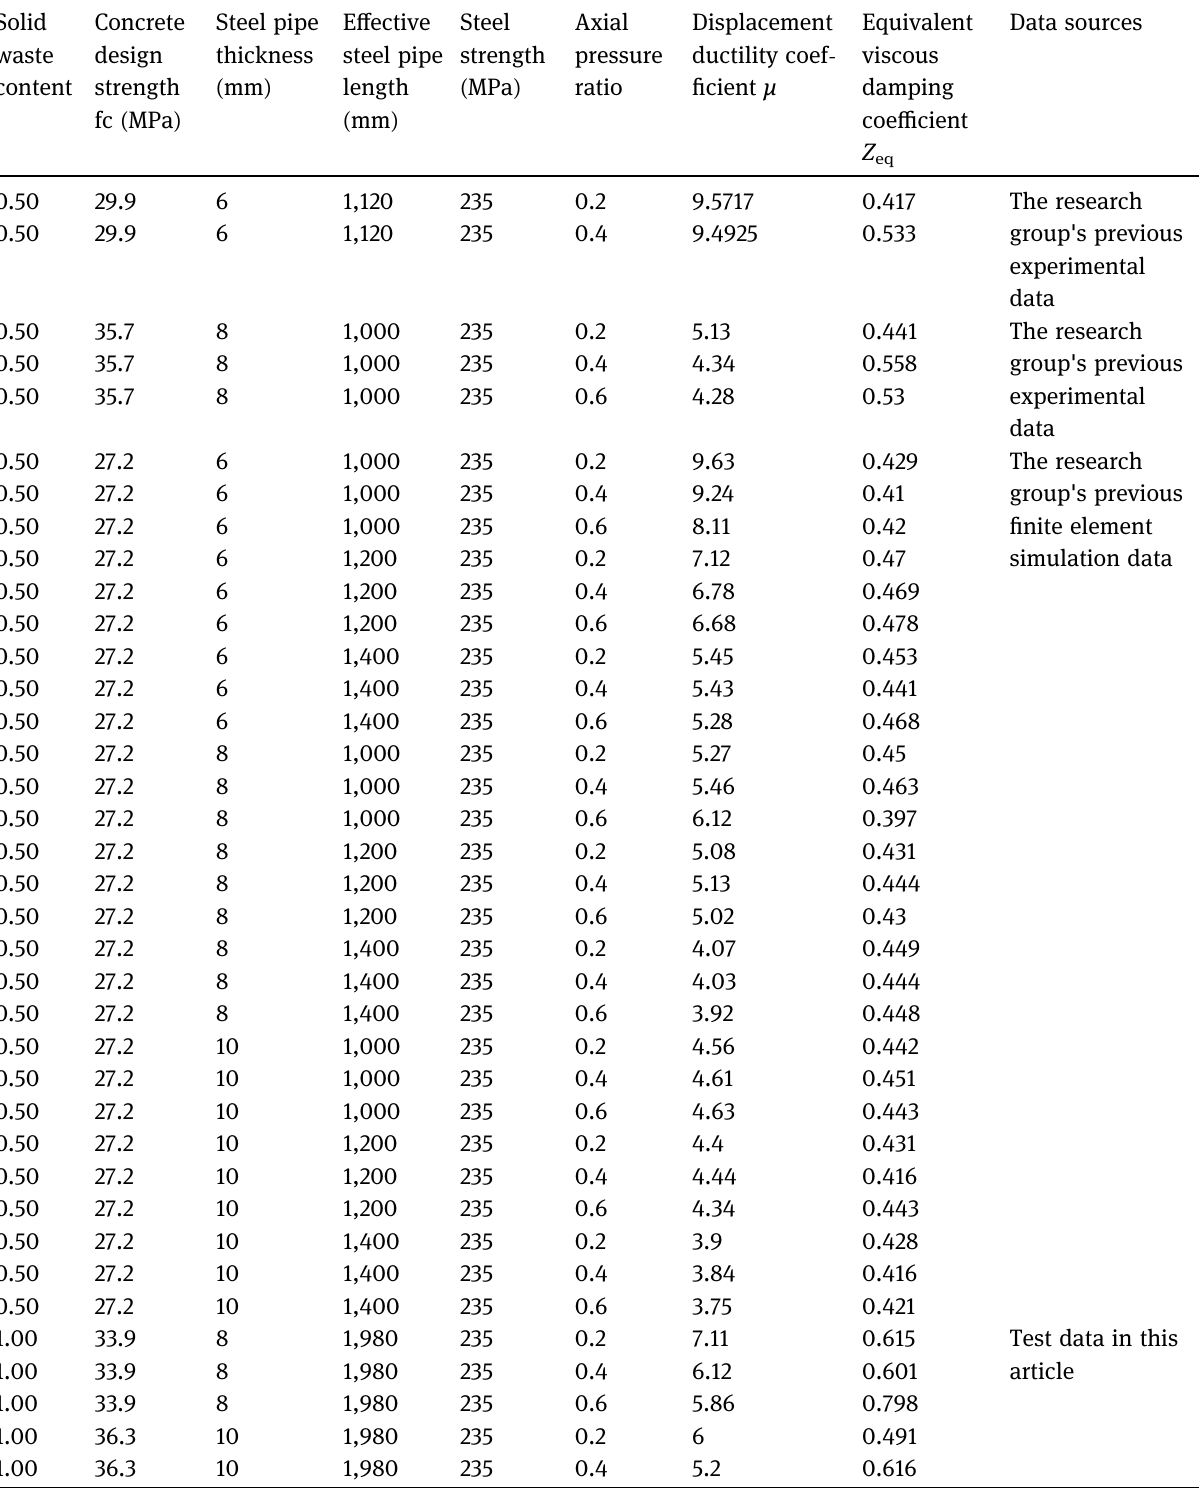
Table of ductility coe ffi cient and equivalent viscous damping coe ffi cient of each specimen